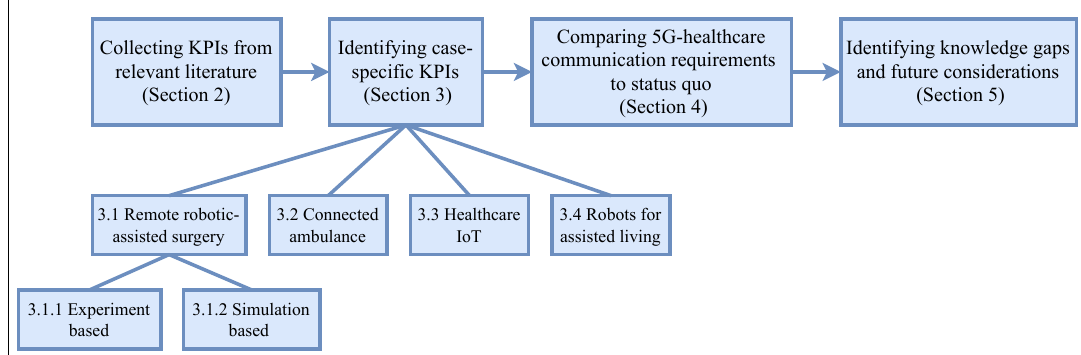
Figure 1. Methodology and organization of